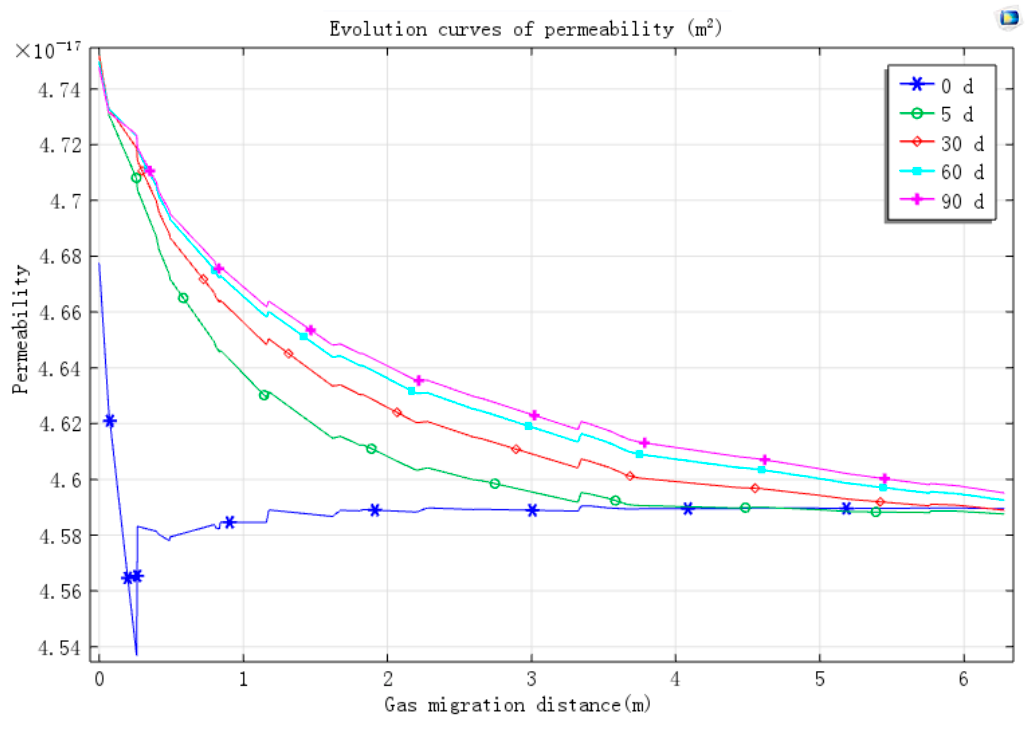
Figure 8. Evolution curves of porosity.